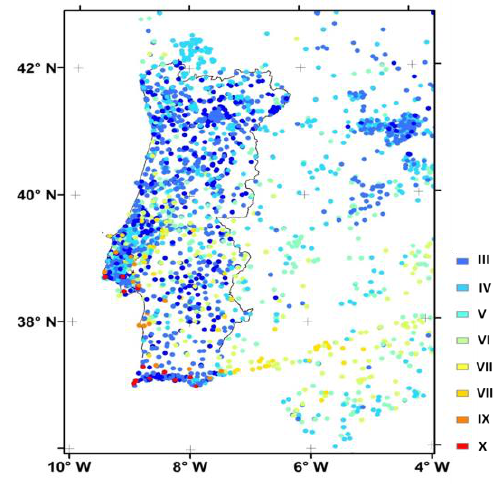
Figure 2. Geographical distribution of the collected IDP Geographic Information System (GIS) technology was used to compile and process all seismic data. After georeferencing all IDPs in GIS, it was found some spatial heterogeneities, related with the spatial density of IDP’s. Many localities, where the intensity is not known, were identified. This fact does not mean that the earthquake was not felt, but only that the intensity was not reported. For this reason, a methodology based on kriging